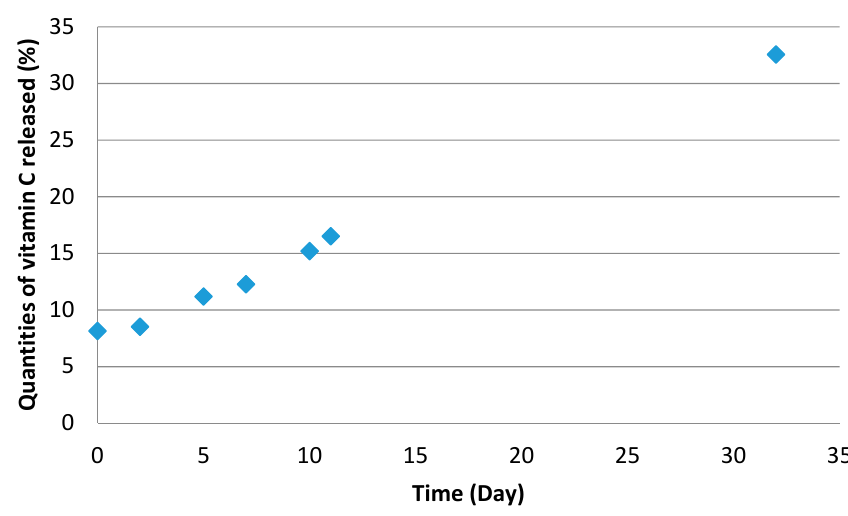
Figure 11. Release of vitamin C as a function of time.